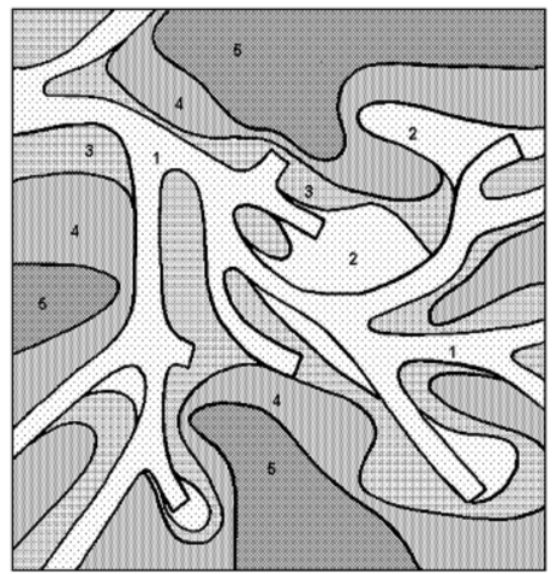
Figura 1. Distribuição espacial das cinco classes de perturbação no hectare central da parcela manejada do bloco 1 (100 x 100 m). Classe 1-trilha de trator (TT), Classe 2-centro da clareira (CC), Classe 3-borda clareira/floresta (BC), Classe 4- borda floresta/clareira (BF), Classe 5-floresta remanescente (FR) (Biot et al.,